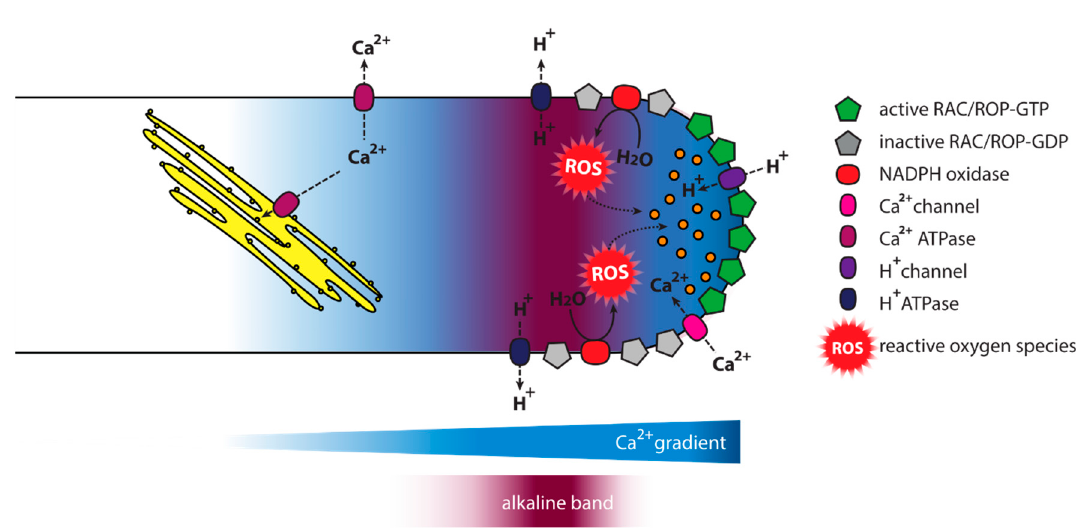
Figure 2. A complex signalling network is involved in pollen tube growth. Pollen tube growth is controlled by a variety of signalling factors, including ions, reactive oxygen species (ROS), and small Rop/Rac-GTPases cycling between active and inactive states. Furthermore, different phosphoinositides and derived lipids are involved in pollen tube growth regulation (See Figures 3 and 4).